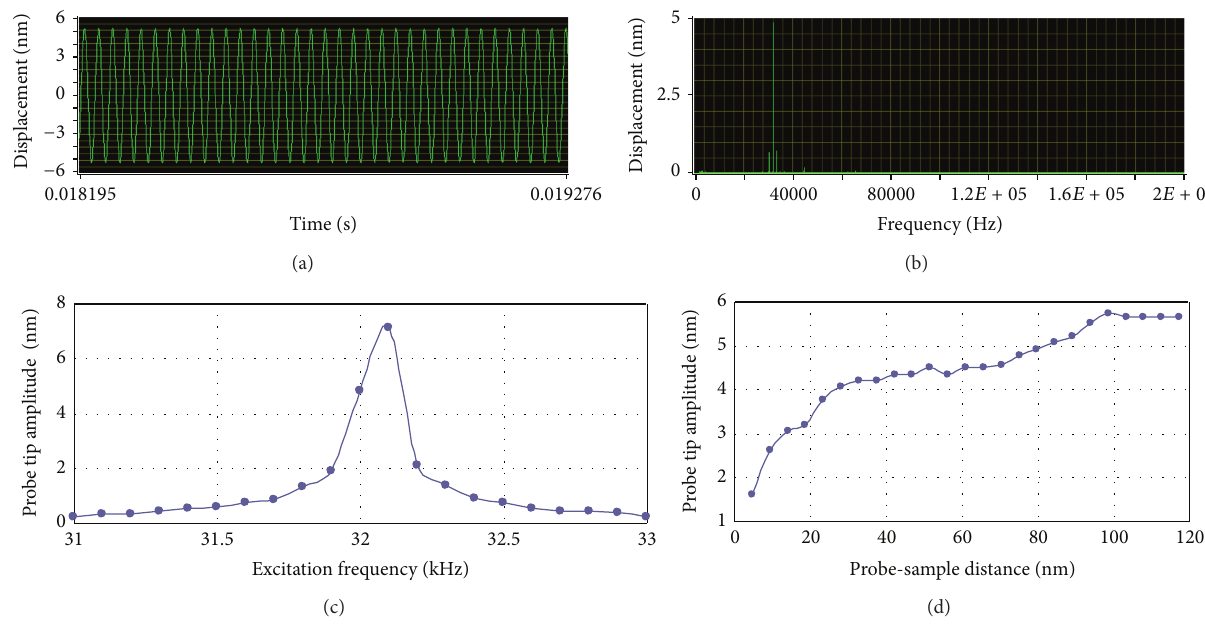
Figure 12: (a) Displacement of the probe tip in a few periods when excited at 32 kHz; (b) spectrum of displacement shown in (a); (c) the frequency-amplitude curve of the TF probe assembled structure in the ambient environment; (d) the amplitude of the probe tip approaching a wet sample surface.